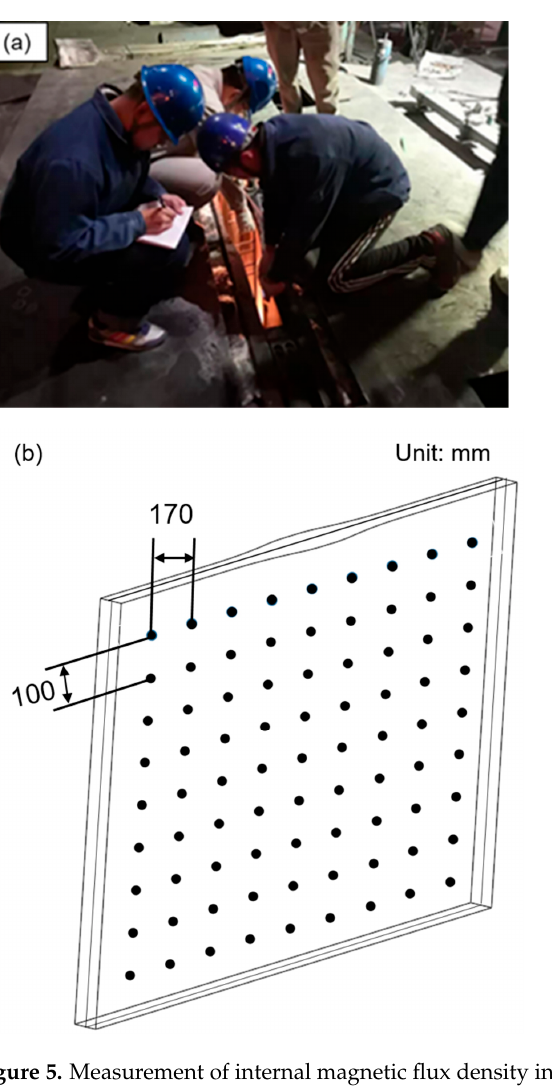
Figure 5. Measurement of internal magnetic flux density in funnel mold. ( a ) Field measurement and ( b ) measuring method.